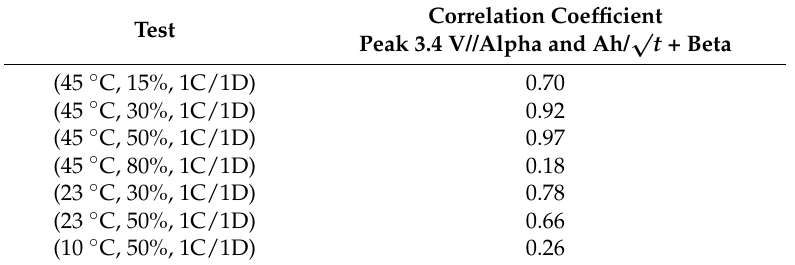
√ t + beta) for different